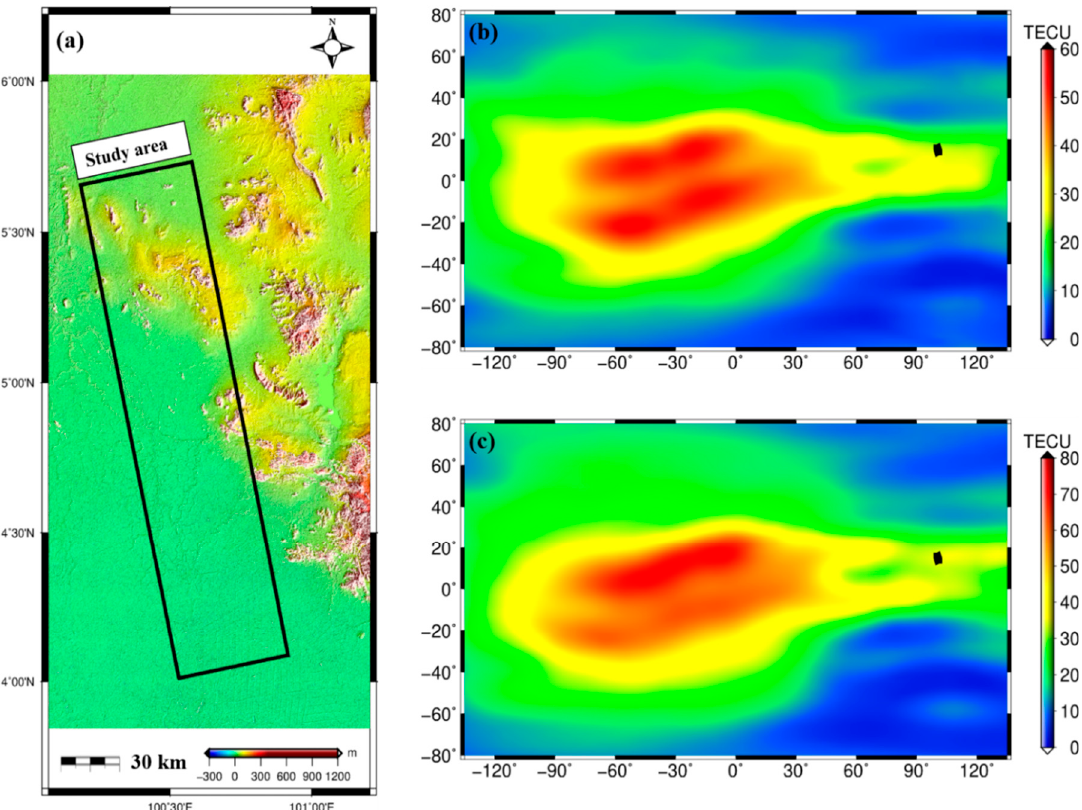
Figure 9. Experimental region and the International Global Navigation Satellite System (GNSS) Service (IGS) VTEC maps. ( a ) Experimental area; ( b , c ) IGS VTEC maps at 16:00 (UT) on 26 March 2010 and 29 March 2011, respectively. The black rectangle denotes the spatial coverage of SAR images.